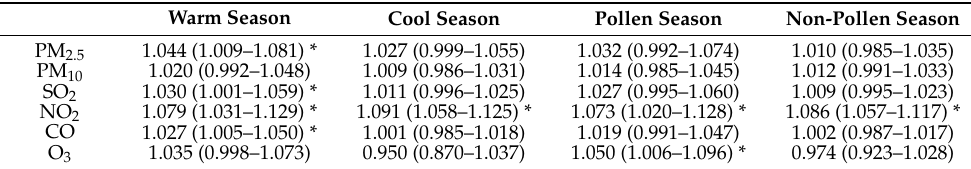
Table 2. Relative risks (RRs) of outpatient visits for allergic rhinitis associated with an IQR increase in the air pollutants for different seasons a .